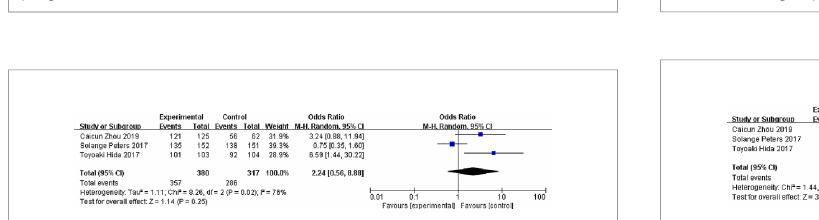
FIGURE 8 | Meta-analysis of partial response rate between alectinib group and crizotinib group.